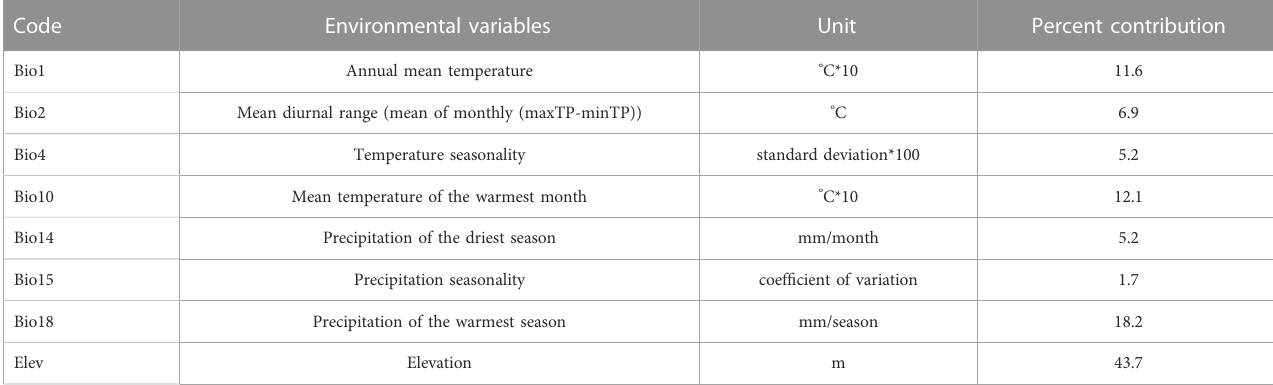
TABLE 1 Environmental variables for Picea and percent contribution to the